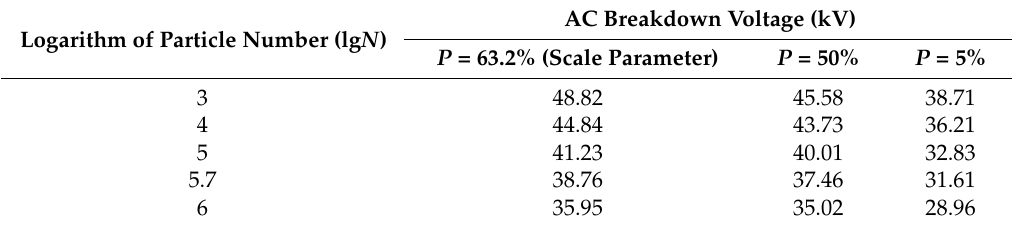
Logarithm of Particle Number (lg N